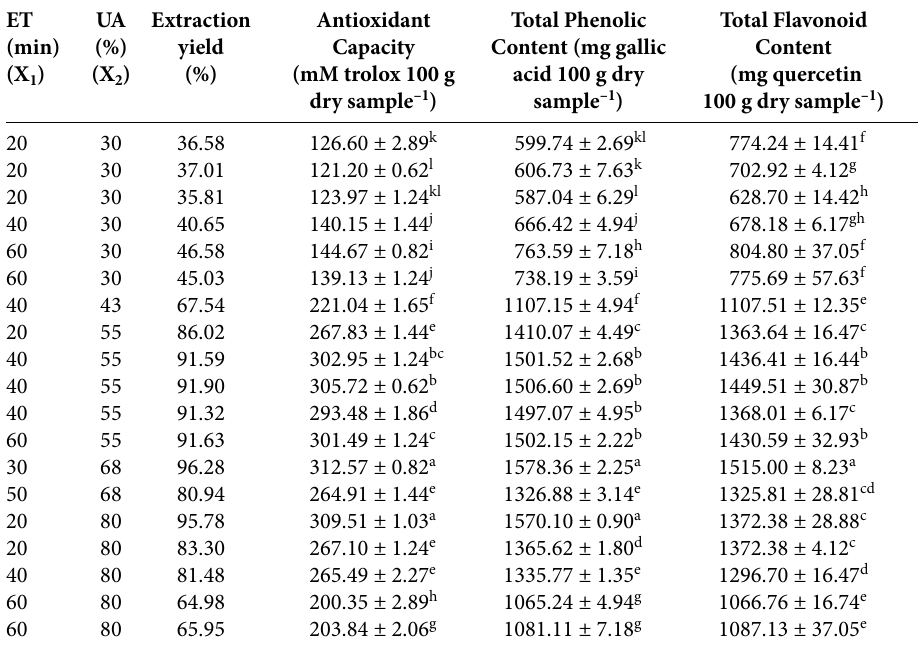
Table 2. Extraction yield, antioxidant capacity, total phenolic and total flavonoid contents for UAE processes ET UA Extraction Antioxidant Total Phenolic Total Flavonoid yield Capacity Content (mg